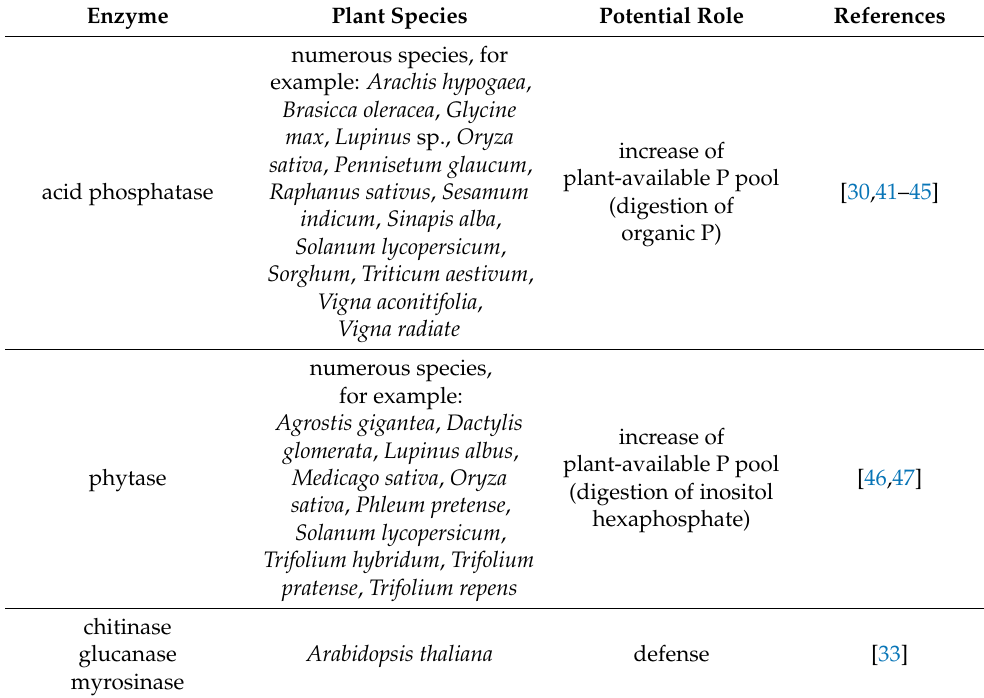
Table 1. Root-derived